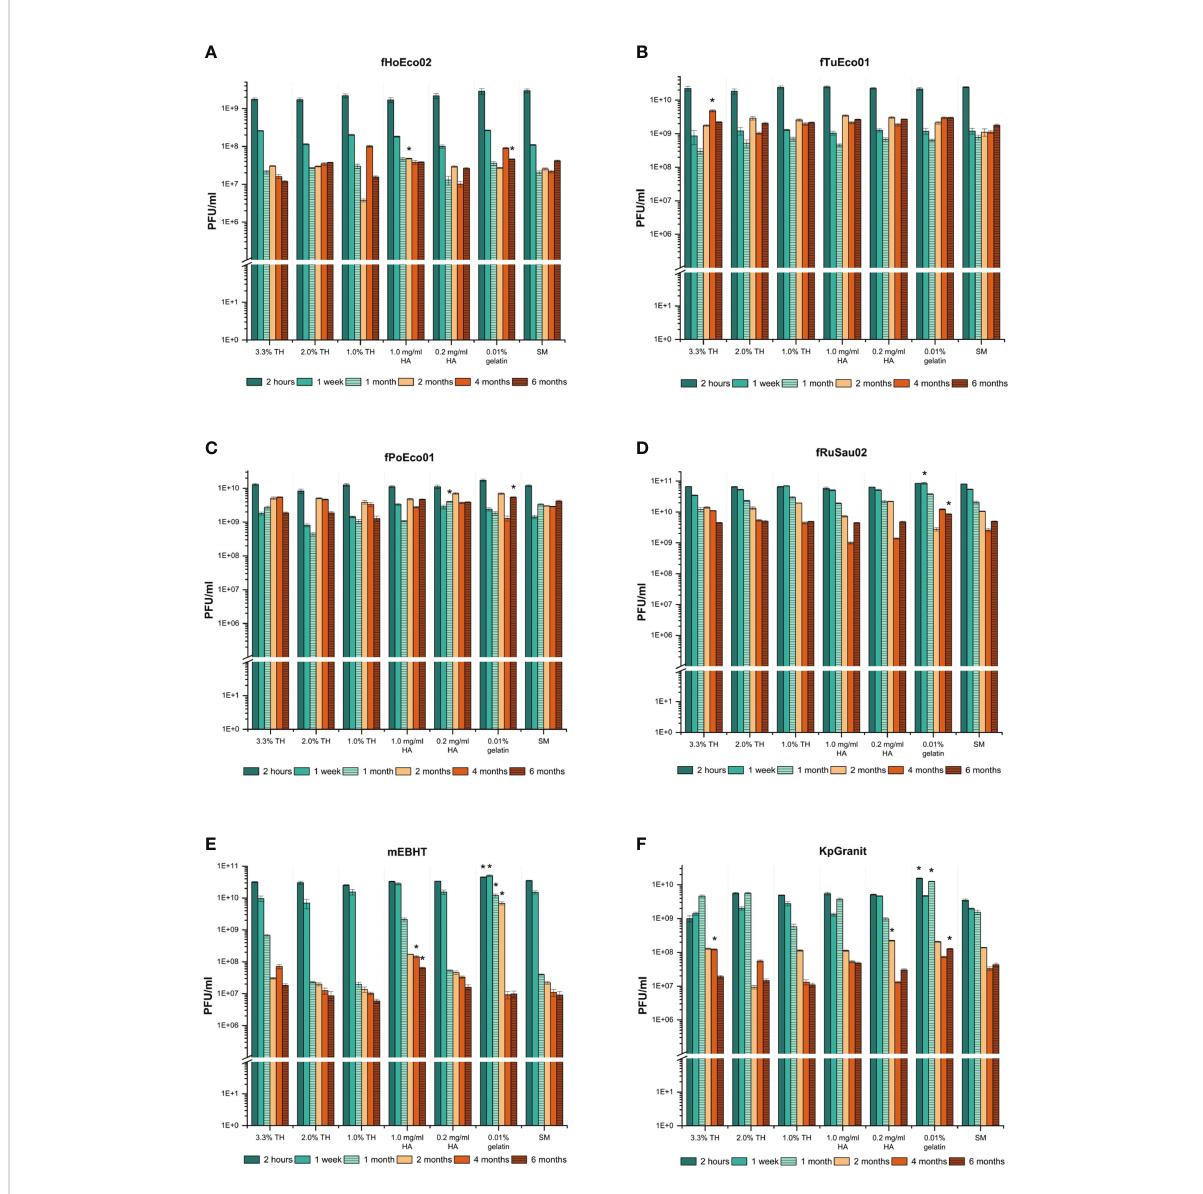
FIGURE 5 Long-term storage of the phages in tubes. Phages fHoEco02 (A) , fTuEco01 (B) , fPoEco01 (C) , fRuSau02 (D) , mEBHT (E) , and KpGranit (F) were stored in 1.0% (w/v) GrowDex hydrogel containing 3.3%, 2.0%, or 1.0% trehalose (TH), 0.2 mg/ml or 1.0 mg/ml hyaluronic acid (HA) and 0.01% gelatin, or without stabilizer (SM) in 2 ml tubes for six months. Phage titrations were performed in triplicate using the double-layer agar method after 2 hours, 1 week, 1, 2, 4, and 6 months of storage time. Bars and error bars indicate mean and SD of PFU/ml, respectively. Asterix indicates a condition where the phage titer was higher than in other conditions tested at a given time point in statistically signi fi cant way, as analyzed by one-way ANOVA ( p -values ≤